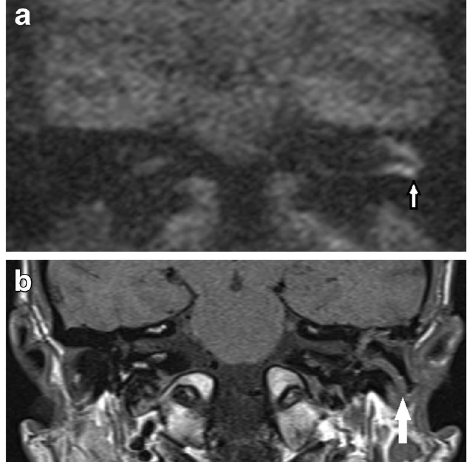
Fig. 7 Case of wax in the ear canal ( white arrow ) mimicking residual disease. The a b1000 image shows parallel high signal, which corresponded to wax in the adjacent ear canal, localised better on b the corresponding non-contrast enhanced T1 weighted image